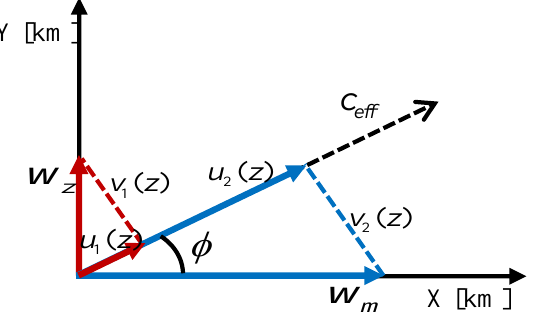
Figure 1. Schematic diagram of effective sound velocity under wind speed. The X -axis indicates the meridional direction; Y -axis indicates the zonal direction. w z is the zonal wind; w m is the meridional wind. u 1 , u 2 and v 1 , v 2 are respectively the components of w z and w m along the direction of infrasound propagation and the components perpendicular to the direction of infrasound